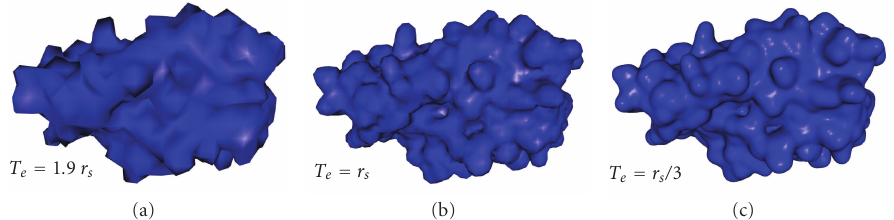
Figure 7: Meshes generated from electron density map at a spatial spacing of T e = 1 . 9 r s (a), T e = r s (b), and T e = r s / 3 (c) (PDB code: 3EBZ).